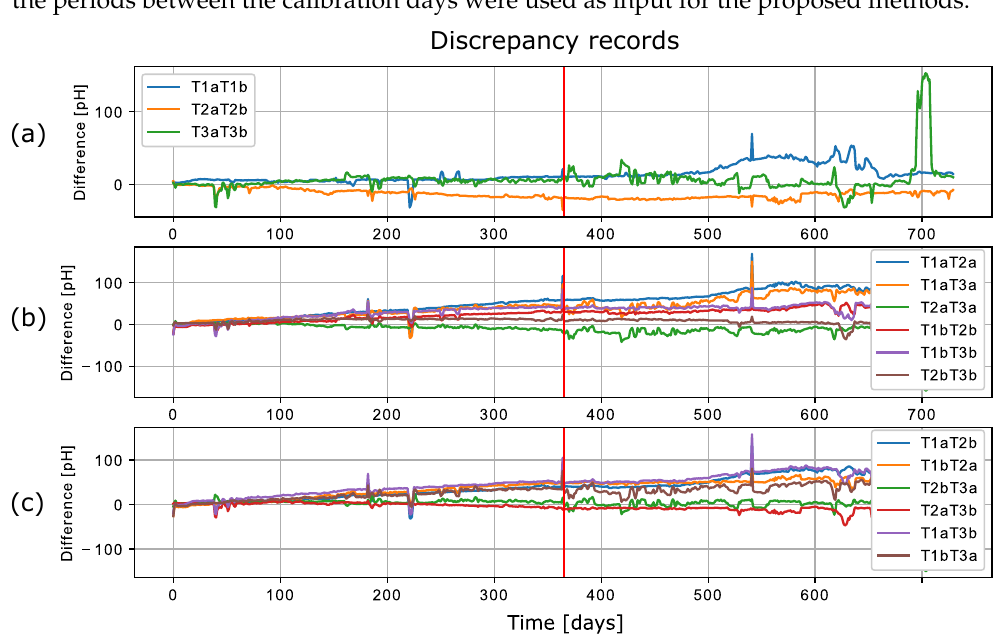
Figure 7. Discrepancy data for six pH sensors presented in [14], where graph ( a ) shows discrepancies of the identical sensors, and ( b , c ) show discrepancies among the rest of the sensors.